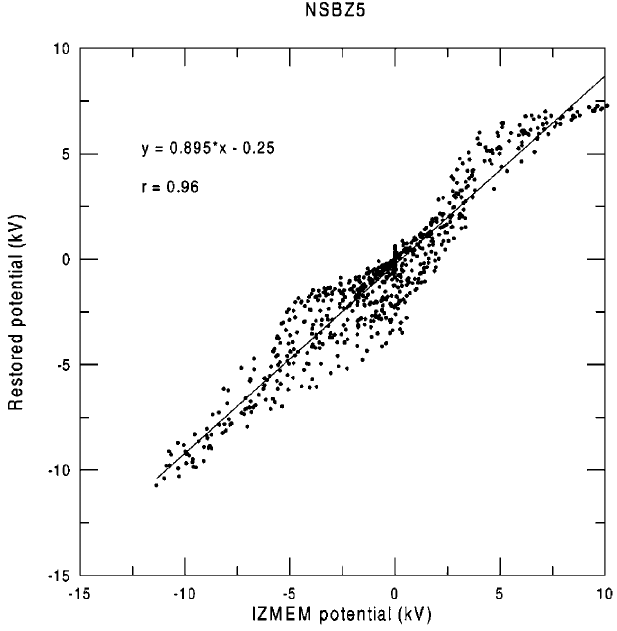
Fig. 8. Reconstructed electric potentials versus the IZMEM/DMSP potentials in the northern summer polar cap for northward IMF ( B x (cid:136) 0, B y (cid:136) 0, B z (cid:136) 5 nT)